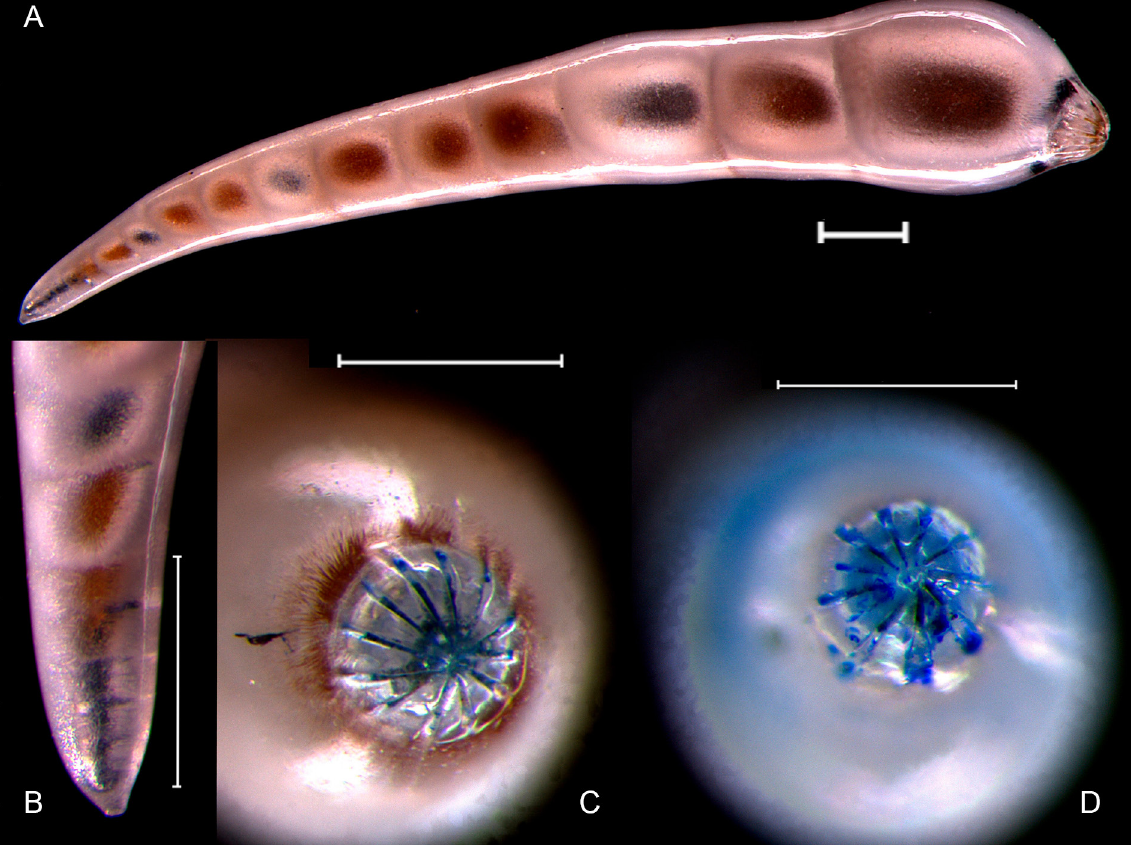
Fig. 5. Dentalina frobisherensis Loeblich & Tappan, 1953. A–C . Megalosphere (BIOICE 3104, IINH 39775), side view (A), details of initial end (B) and aperture (C) stained with indigo blue. D . Megalosphere (BIOICE 3108, IINH 39774), aperture stained with indigo blue. Light source combination of incident light and dark field. Scale bars = 0.25